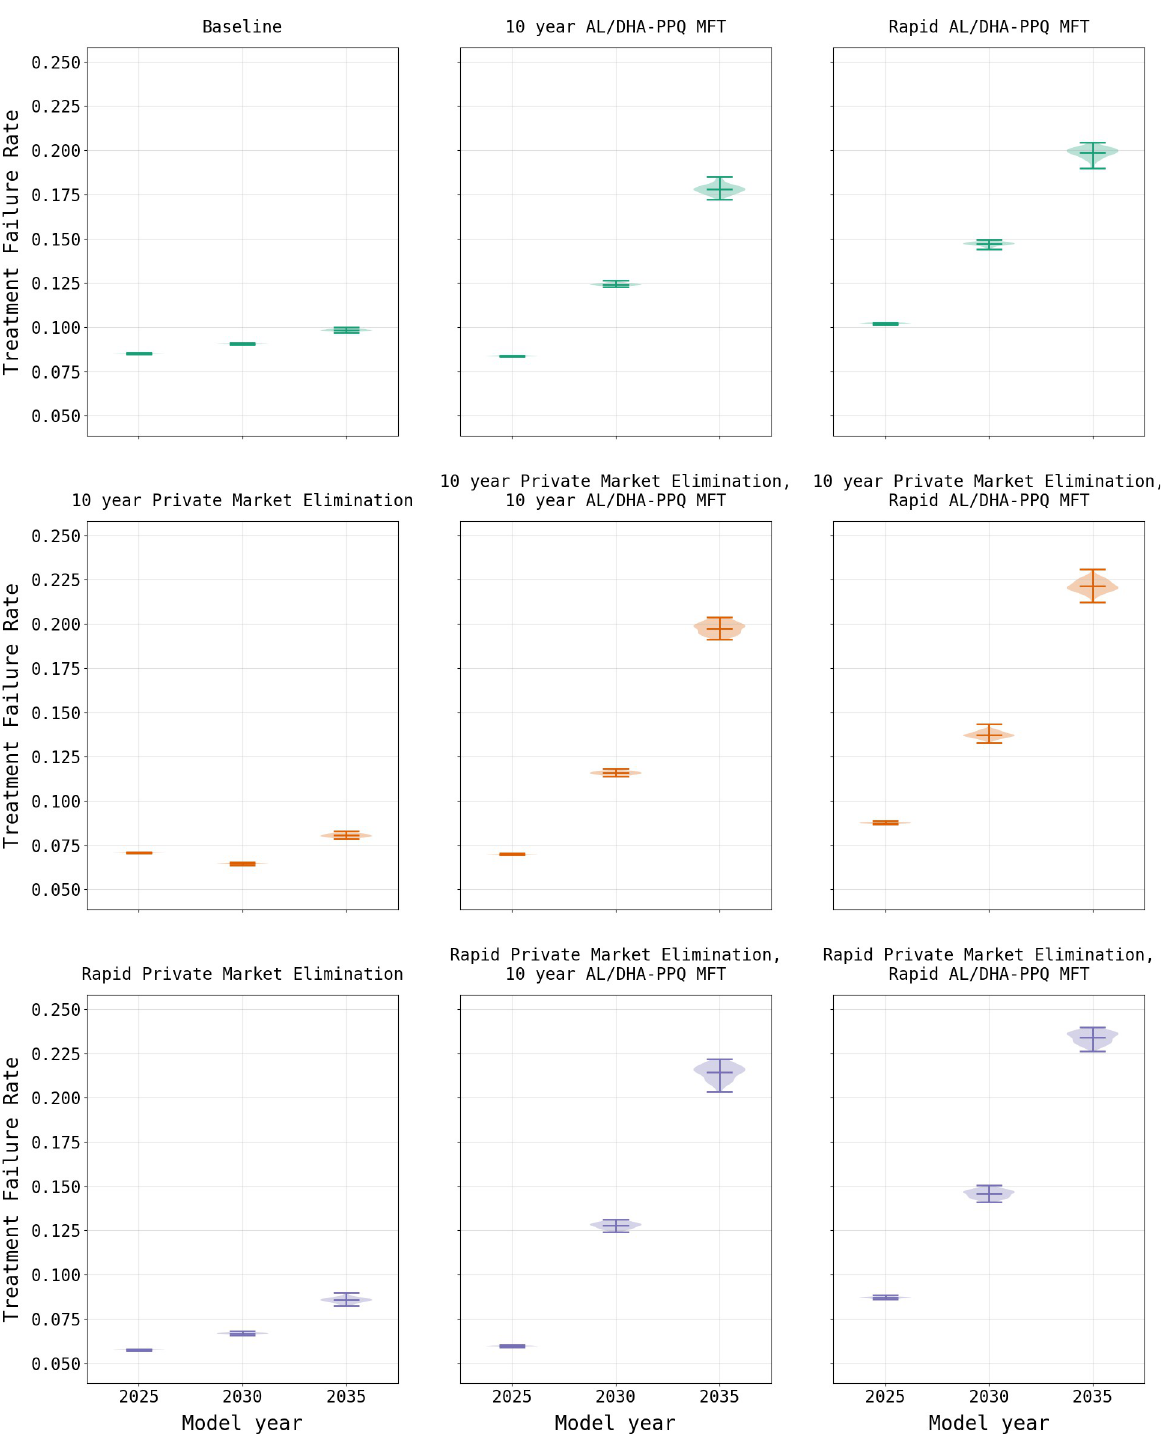
Fig 6. Comparison of treatment failure rates (mean and range) under two policy scenarios. AL/DHA-PPQ MFT refers to a policy of multiple first-line therapies where AL and DHA-PPQ are deployed equally in the population. Evaluations of MFT and private market elimination are shown for rapid (i.e., immediate) implementation and gradual implementation over a 10-year period. Under the baseline scenario the treatment failure rate remains fairly consistent over a 10-year period. With elimination of the private market, the treatment failure rate drops, which is expected given that this approach reduces usage of less efficacious treatments. Introduction of MFT together with elimination of the private market also reduces usage of less efficacious treatments; however, this is rapidly offset by the increased treatment failure rate due to the increasing frequency of plasmepsin-2 , 3 double-copy